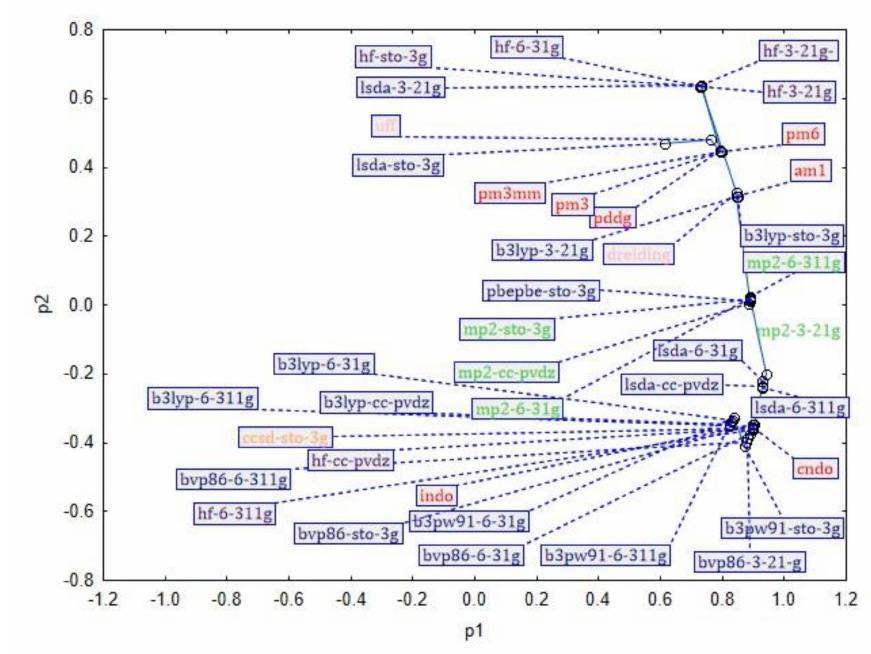
Figure 3. Score plot showing the distribution of the methods in the two principal components.